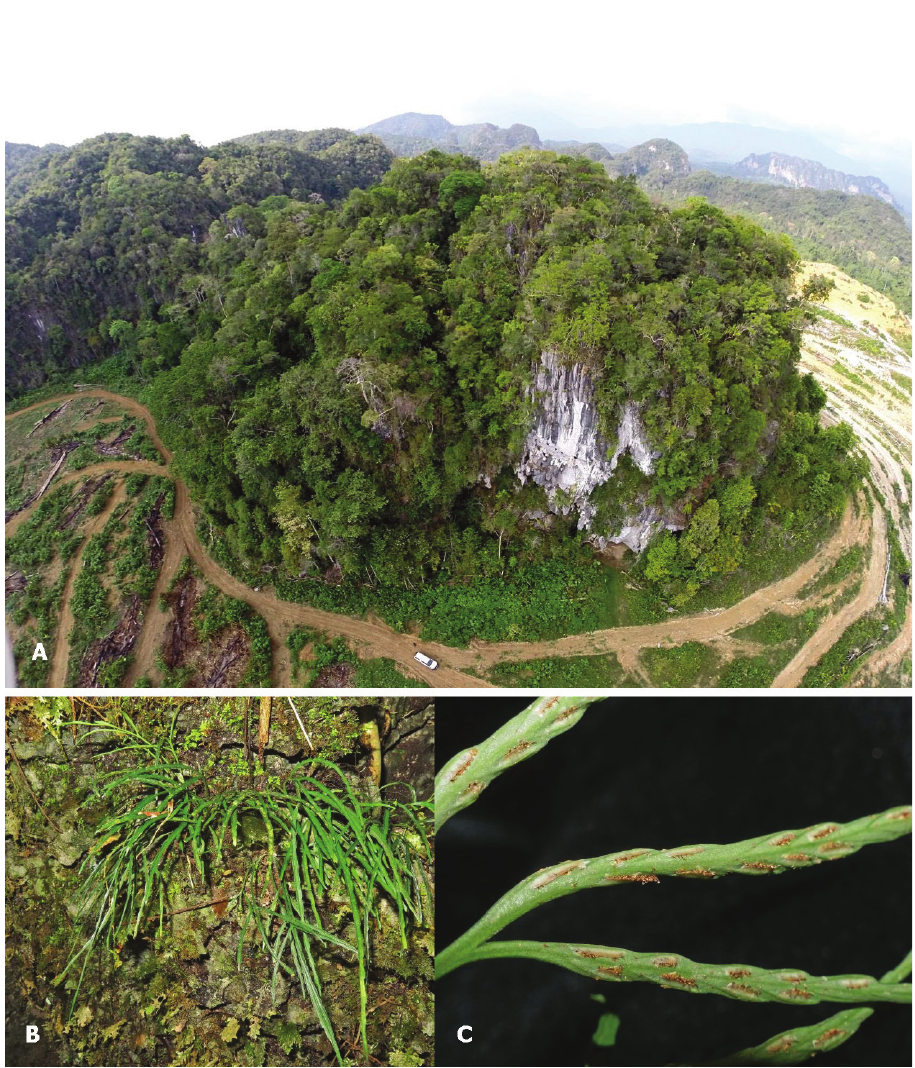
Figure 2. Asplenium merapohense R.Jaman & K.Imin, sp. nov. A Gunung Gajah B habitat – in crevices on a shaded, mossy limestone vertical cliff C Undersurface of a pinna with sori showing indusia. (Photographs by A P.T. Ong, B, C K.